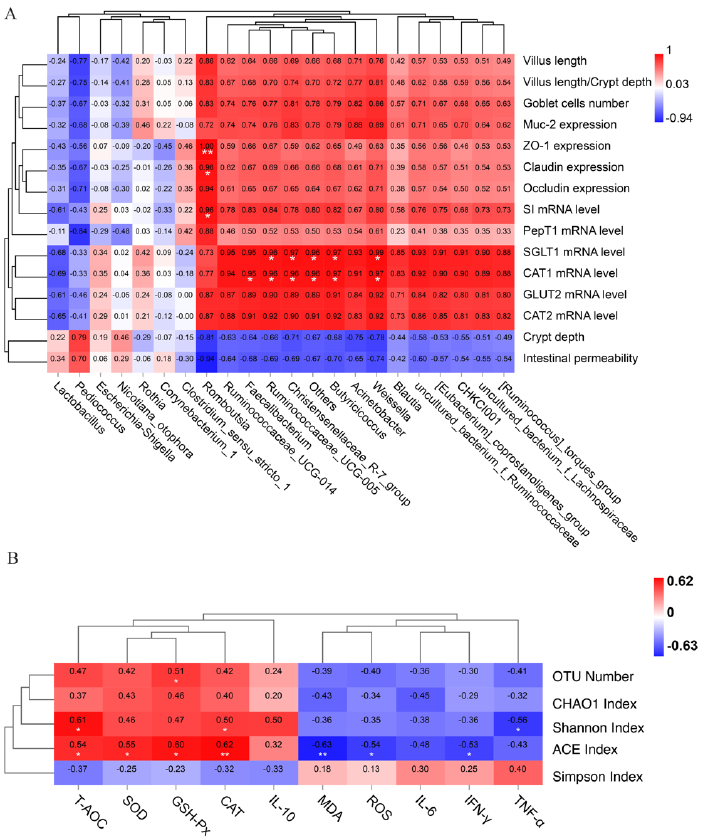
Figure 8. Spearman’s rank correlations between the relative abundances of 22 key phylotypes at the genus level on d 42 and gut health ( A ). Spearman’s rank correlations between the microbial